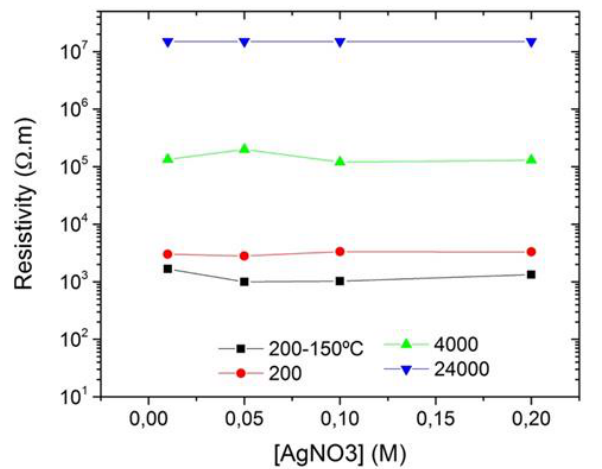
Figure 4. Dependence of the resistivity values with AgNO 3 concentration. 298